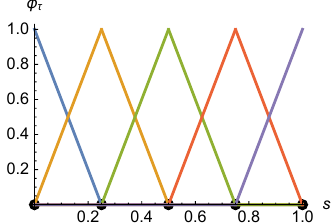
Figure A3. Sets of H 1 finite element basis function φ τ j , j = 1, . . .